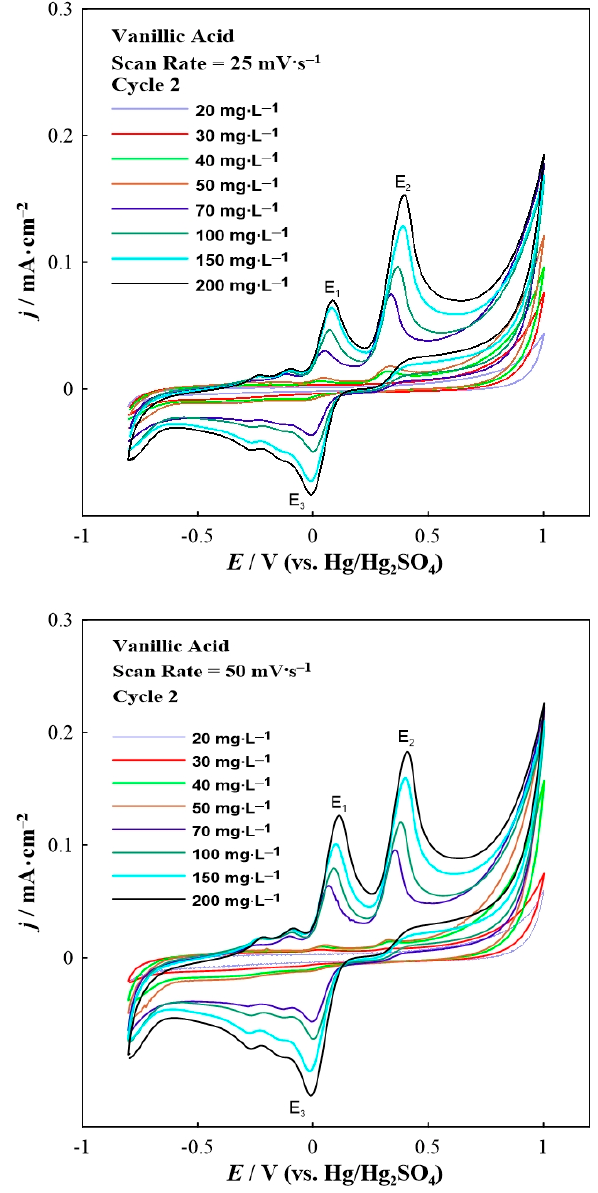
Figure 2. Second scan of the cyclic voltammograms for vanillic acid in various concentrations at a constant scan rate of 25 ( top ) and 50 ( bottom ) mV ∙ s − 1 .